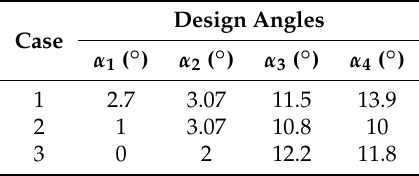
Table 3. Design angles values of the three CFD cases.